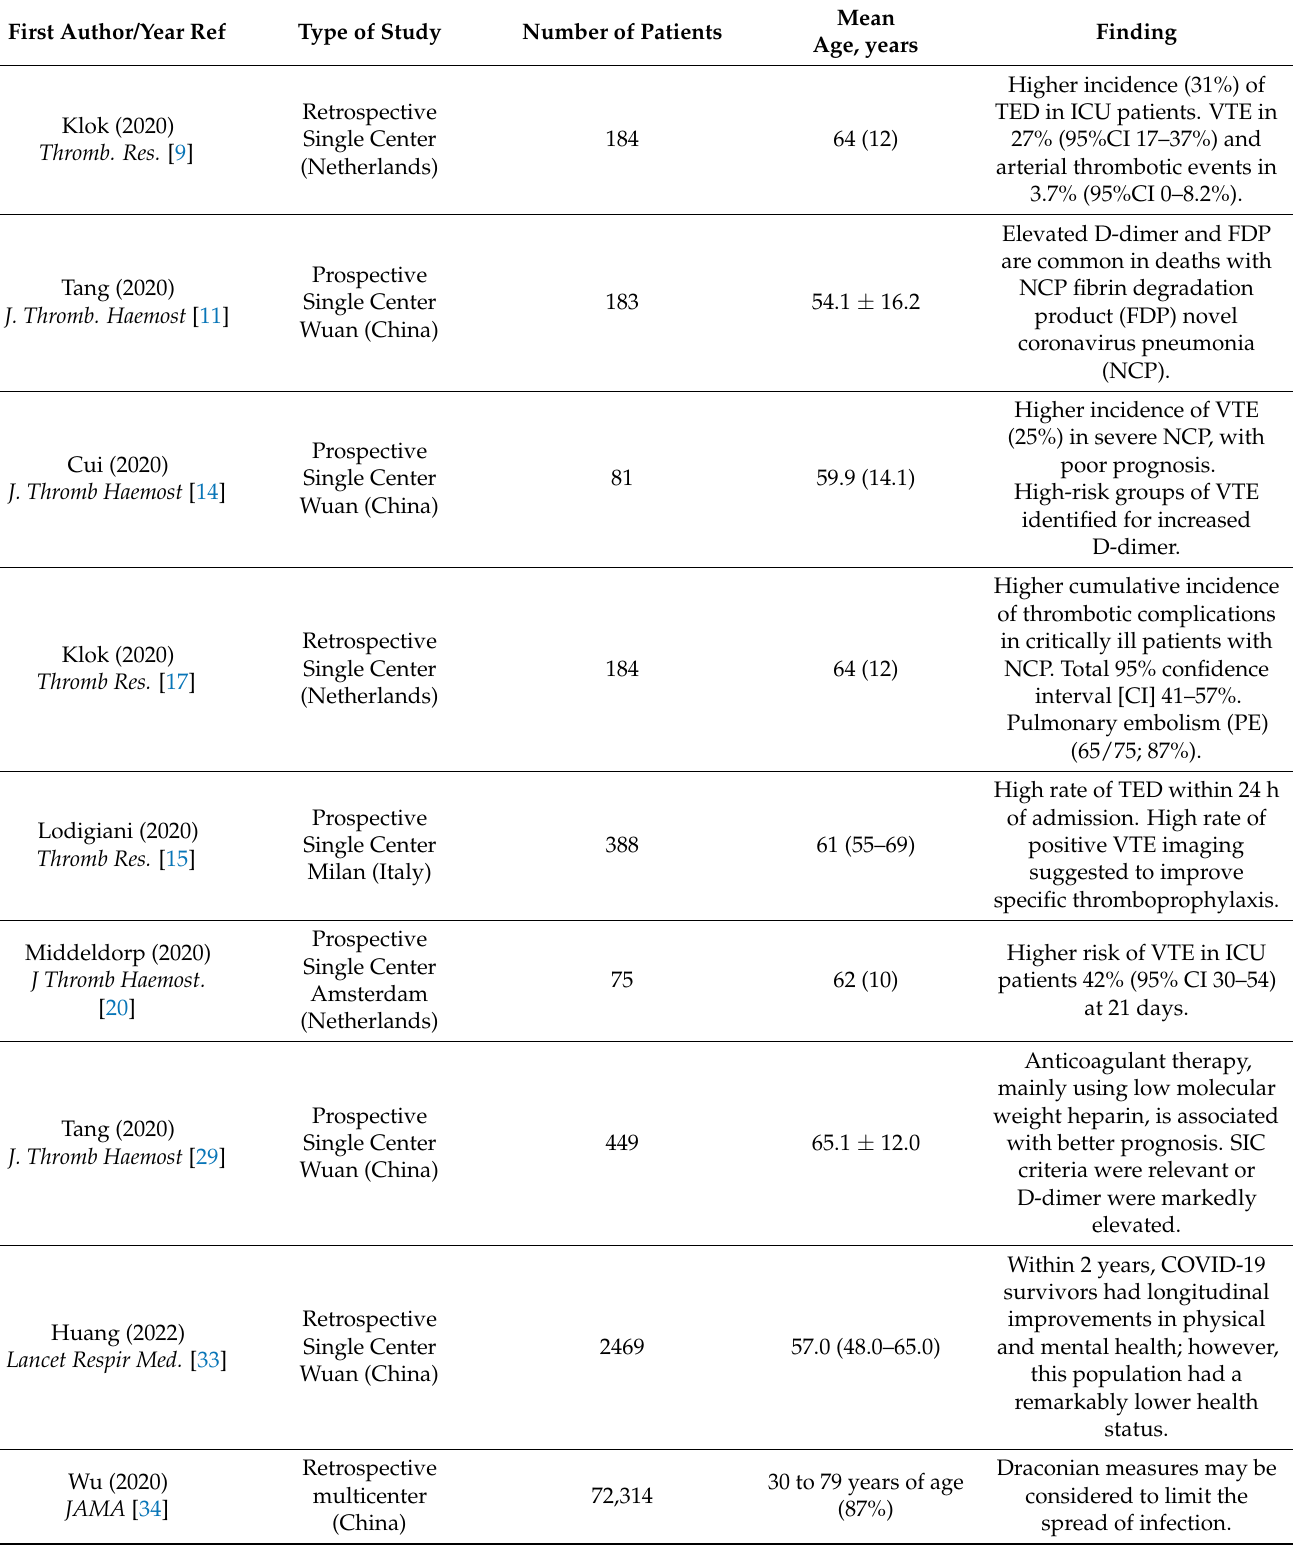
Table 1. Characteristics of the included studies. Abbreviations: DAD, diffuse alveolar damage; SOFA, Sequential Organ Failure Assessment; other abbreviations in other